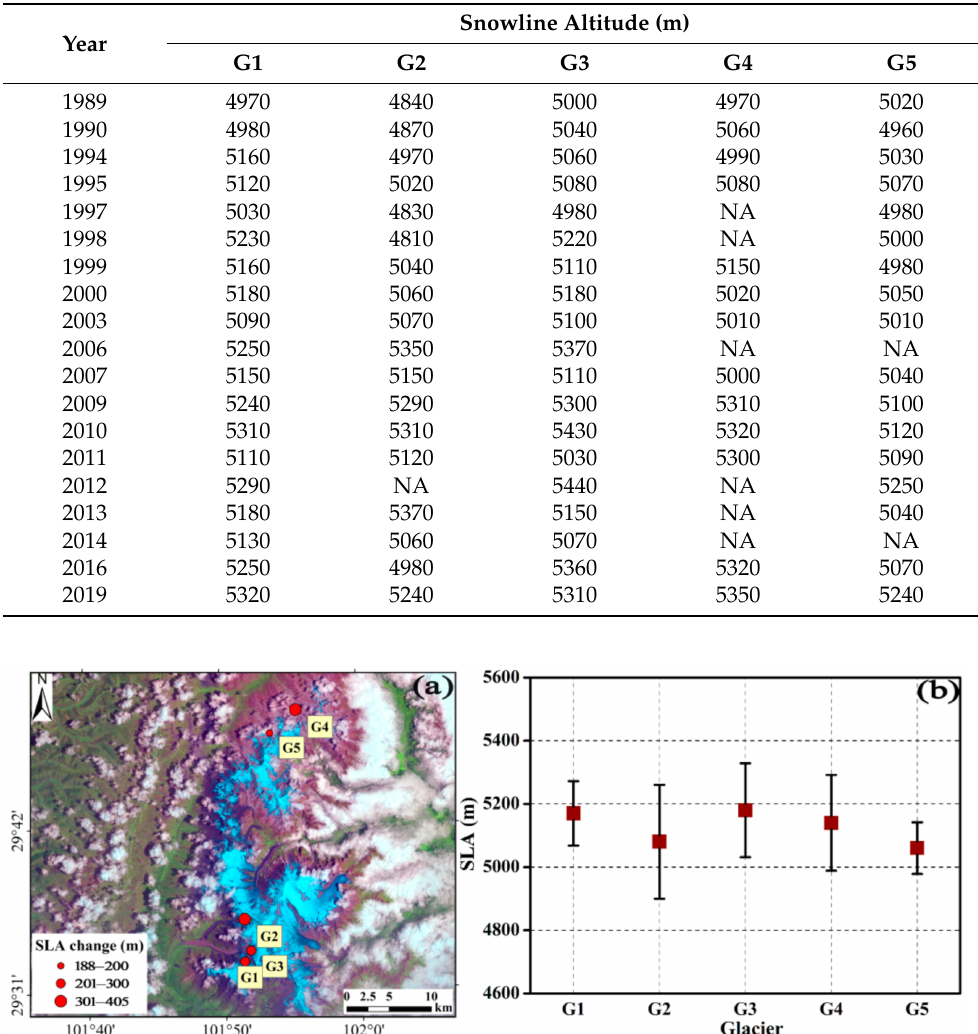
Table 6. SLA of the five analyzed glaciers across the Gongga Mountains during the 1989–2019 period.